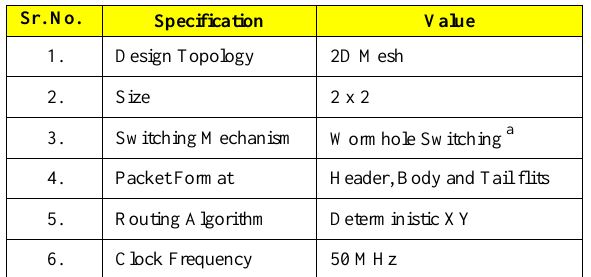
Table 1: NoC Design